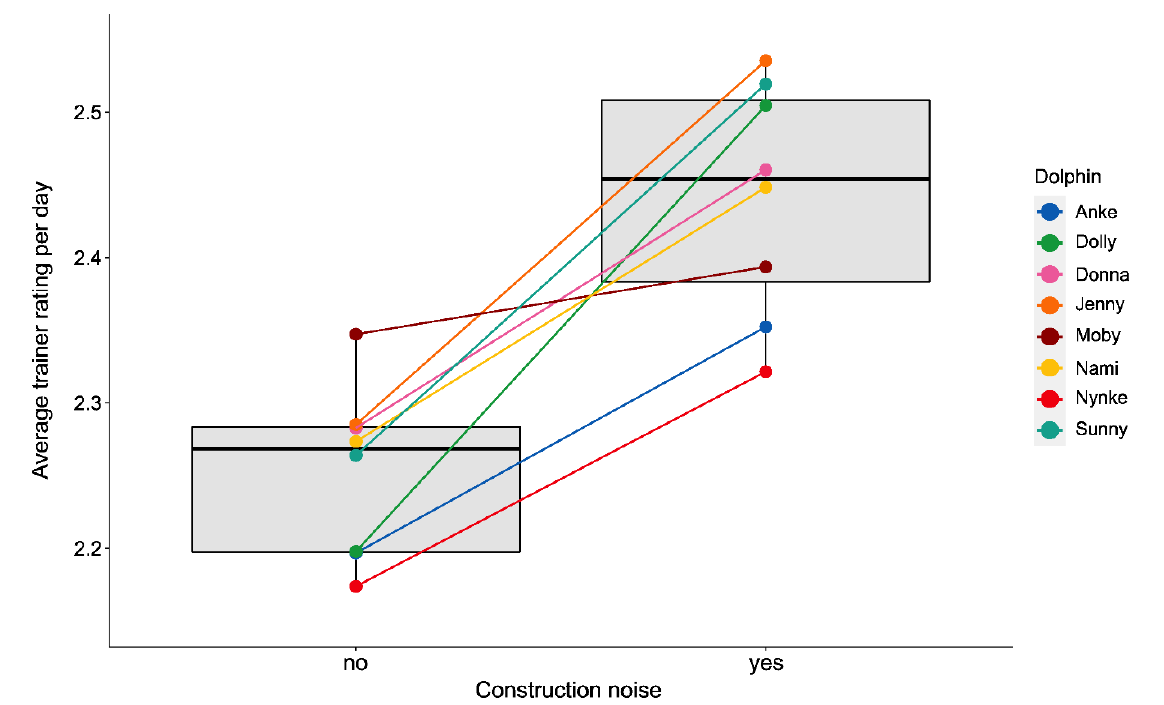
Figure 7. Mean differences in average trainer rating during periods with and without construction noise. All periods with and all periods without construction noise were pooled to deduce a mean value for each individual.